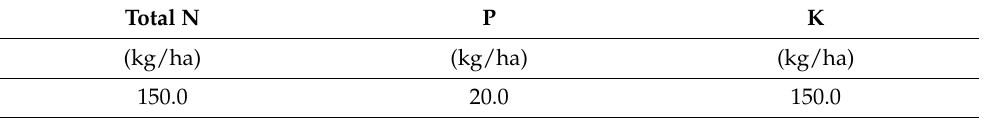
Table 4. Specifications of applied NPK in relation to the application of nutrients per hectare of soil.